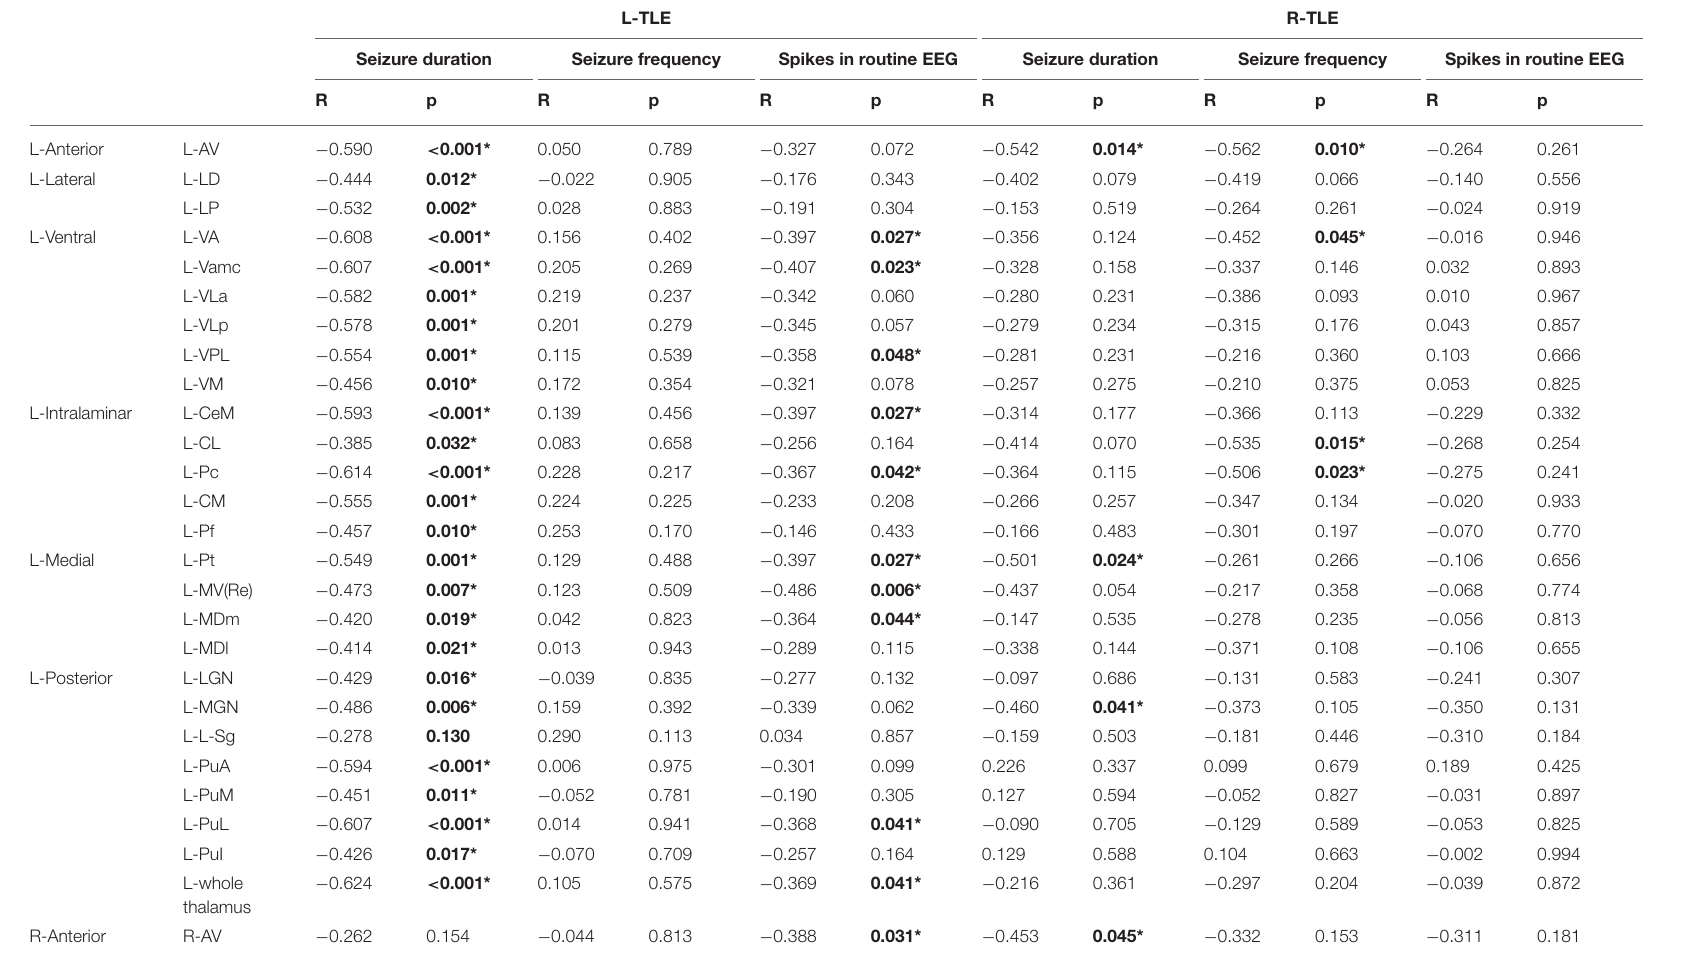
TABLE 3 | The relationship between hippocampus subfield volumes and the clinical